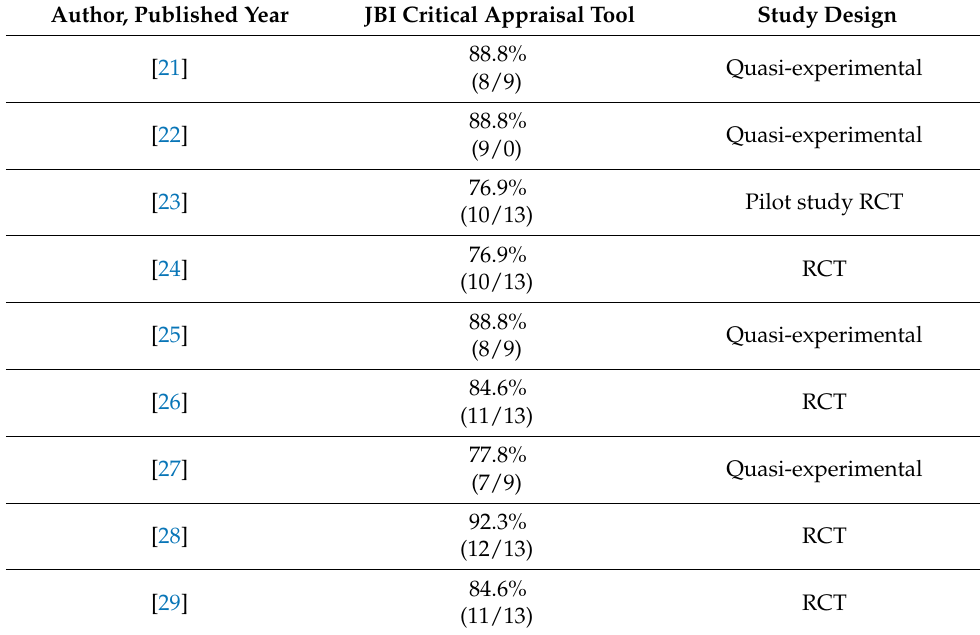
Table 1. JBI Critical Appraisal Tool.